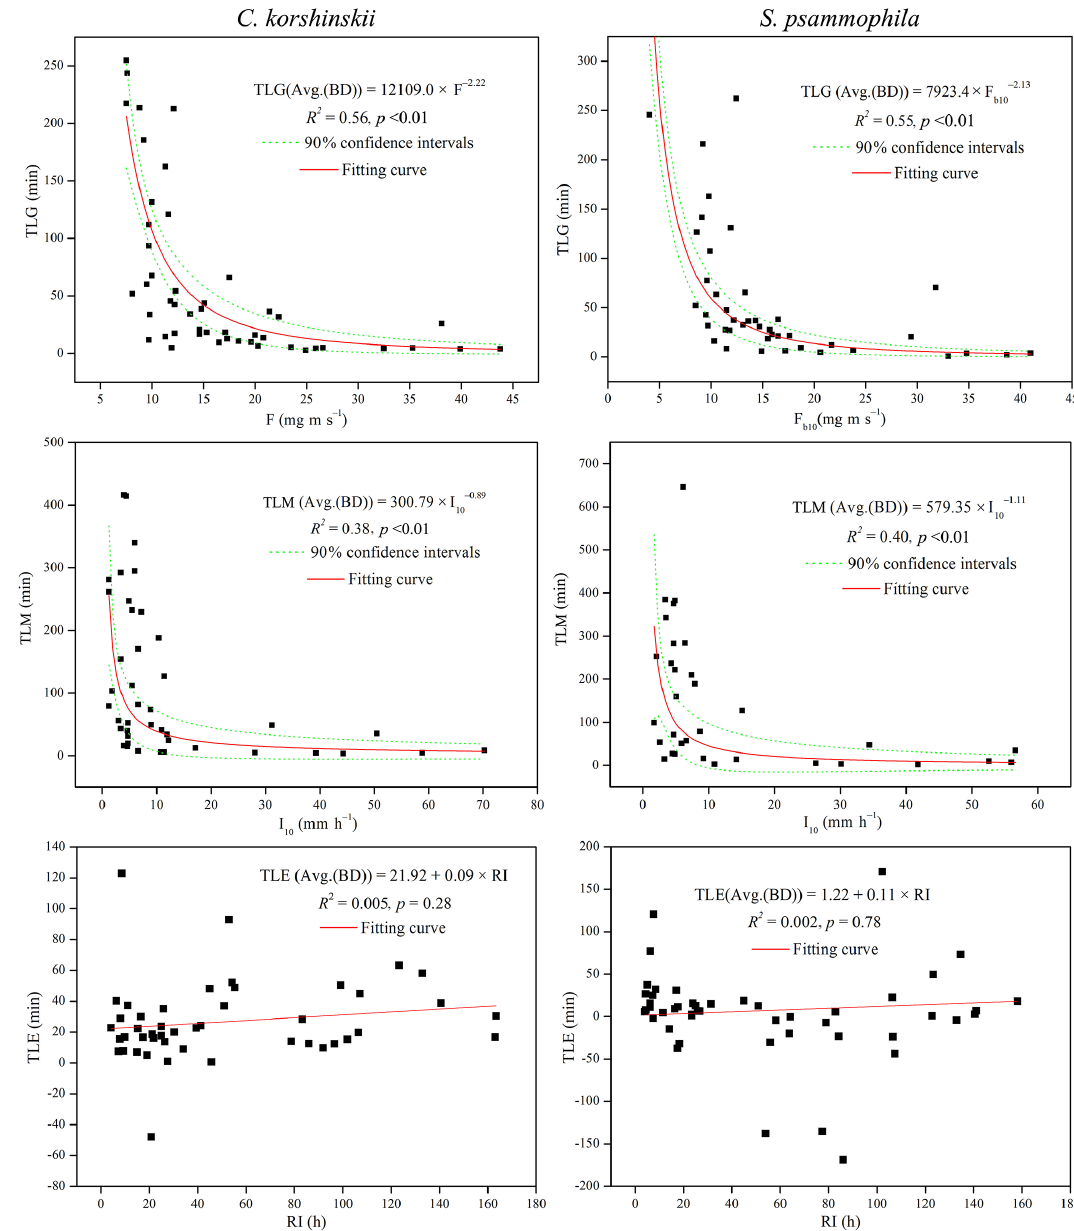
Figure 7. Relationships of stemflow time lags with rainfall